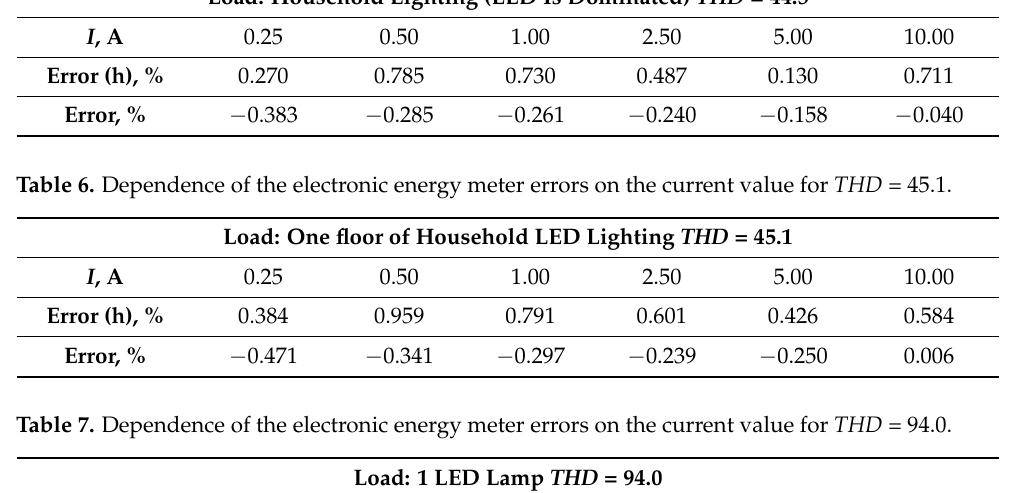
Table 5. Dependence of the electronic energy meter errors on the current value for THD = 44.5. Load: Household Lighting (LED Is Dominated) THD = 44.5